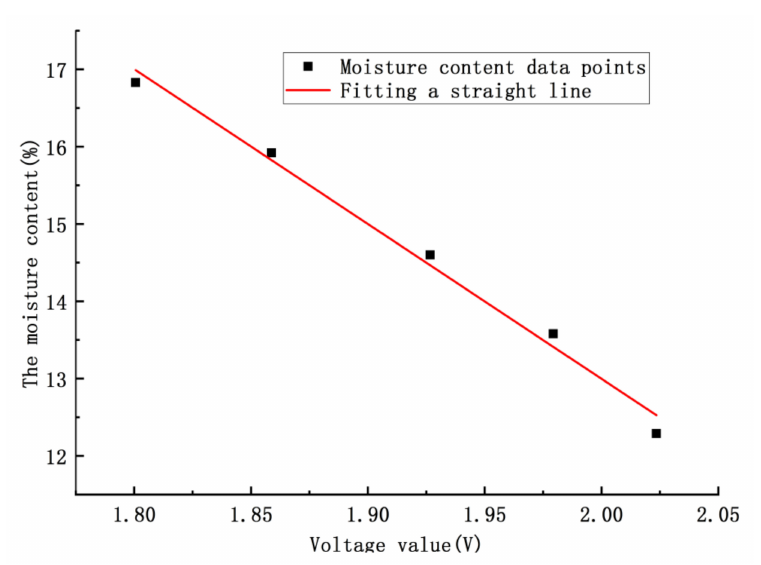
Figure 19. The voltage–moisture characteristic parameter mathematical